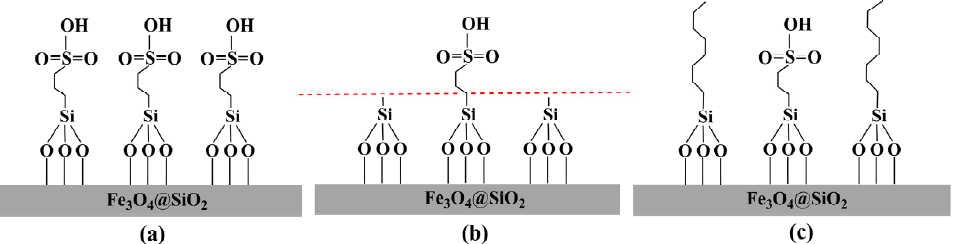
Figure 14. Comparison of the molecular length of propylsulfonic acid, methyl and octyl. ( a ) Fe 3 O 4 @SiO 2 -PrSO 3 H, ( b ) Fe 3 O 4 @SiO 2 -Me&PrSO 3 H and ( c ) Fe 3 O 4 @SiO 2 -Oc&PrSO 3 H.